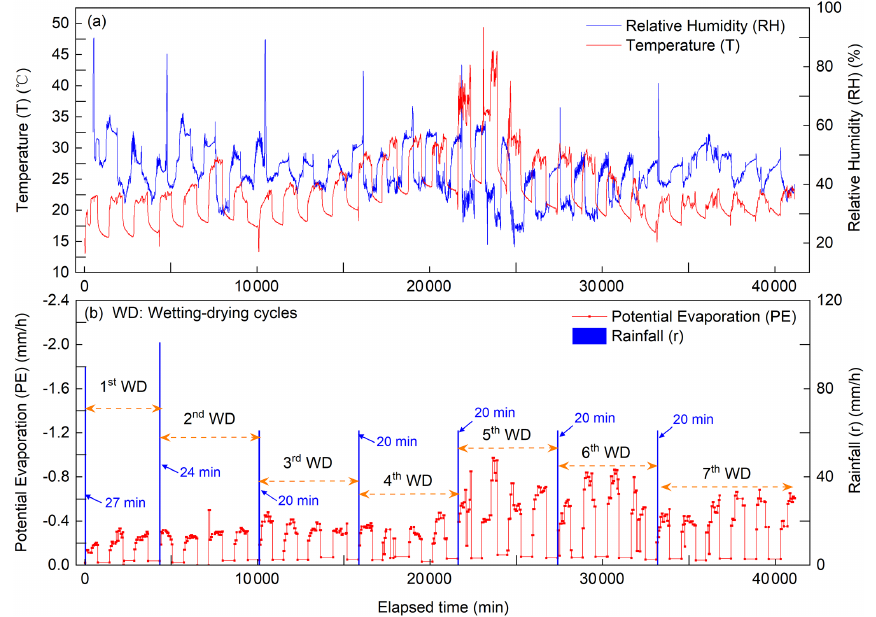
Figure 4. Environmental conditions of the experiment. (a) Time series of temperature and relative humidity. (b) Rainfall intensity and potential